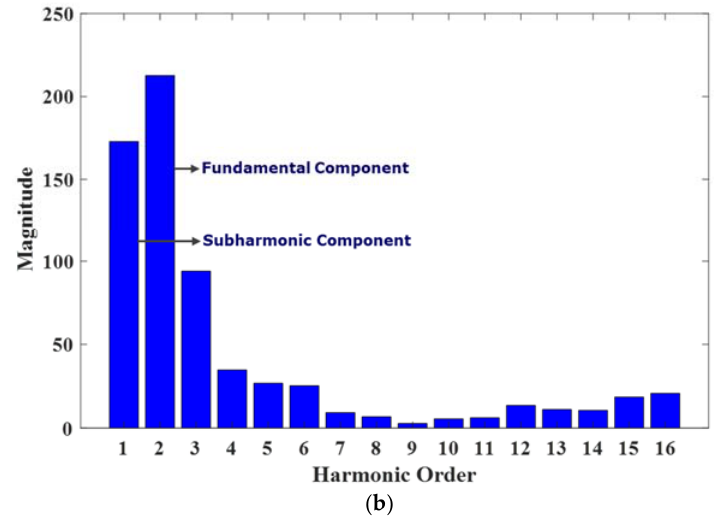
Figure 6. For proposed machine: ( a ) MMF Plot and ( b ) harmonic distribution.